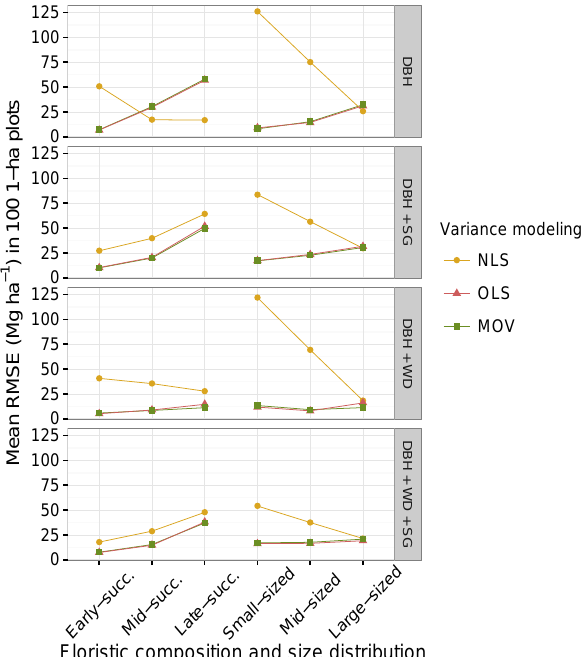
Figure 4. Profiles relating the bias of 12 aboveground tree biomass estimation models tested along six forest scenarios composed of 100 1ha plots. Forest scenarios were designed to reflect landscape- level variations in floristic composition and size distribution of trees, typical of central Amazonian terra firme forests. Models’ predictors: diameter at breast height (DBH) (cm), species’ succes- sional group (SG) (pioneers, mid- and late successional) and wood density (WD) (gcm − 3 ) . Variance modeling approaches: nonlinear least square (NLS), ordinary least square with log-linear regression (OLS) and nonlinear with modeled variance (MOV). Note that mod- els containing tree total height ( H ) as predictor were excluded here.